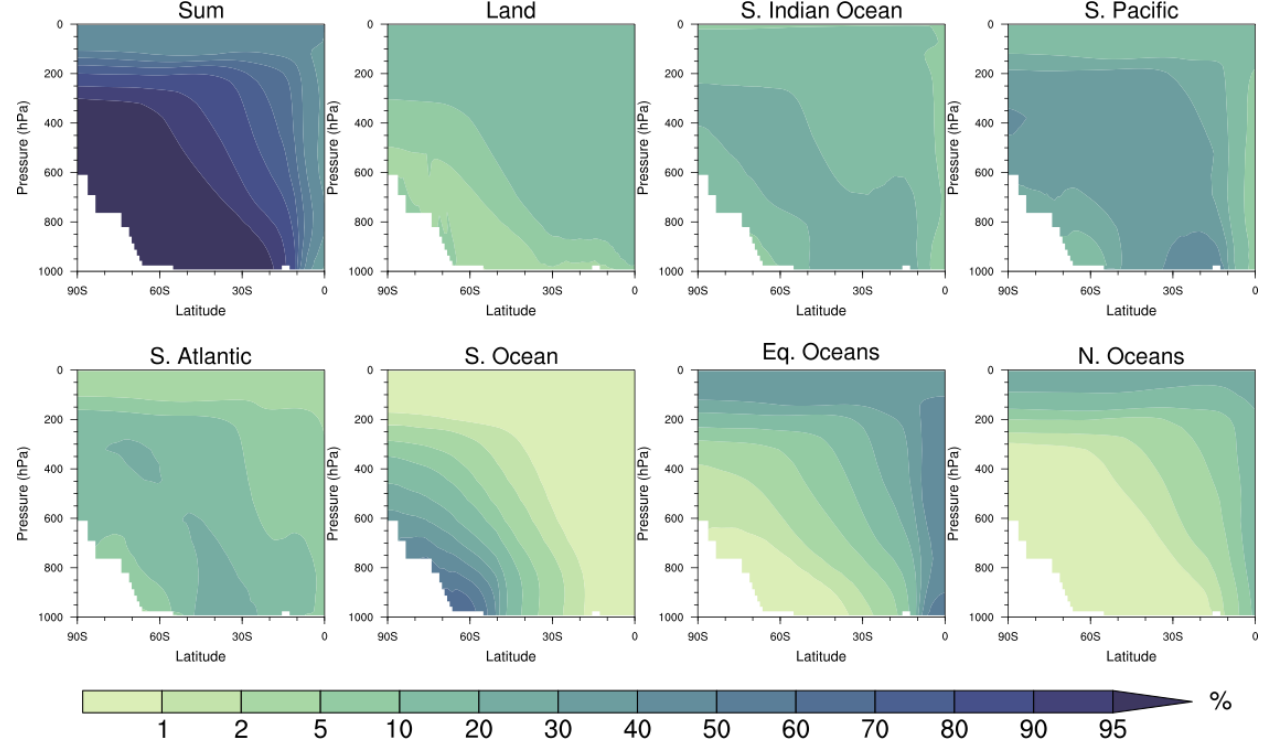
Figure 7. Vertical distribution of fractional contribution (%) to annual and zonal mean water vapor mixing ratio from individual source regions in the mean case. The “Sum” (upper-left panel) represents contributions from the five major source regions, including land, southern Indian Ocean, South Pacific, South Atlantic and Southern Ocean. The Southern Ocean tag here includes all six sub-sectors. Equatorial oceans include the three equatorial ocean tags, and northern oceans include the remaining ocean tags in the Northern